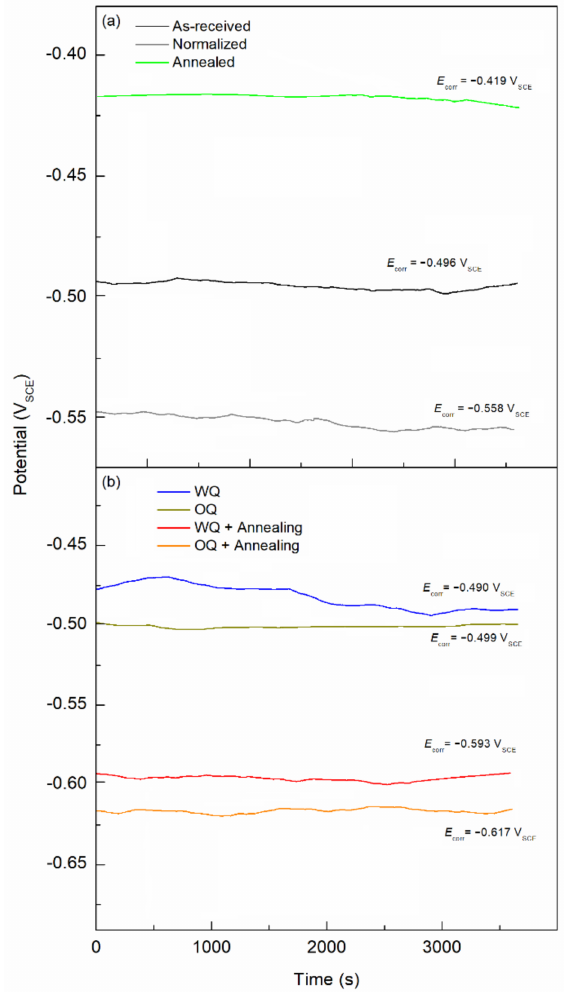
Figure 4. Open circuit potential obtained during 1 h for the sample exposed to FA pore solution containing 0.6 M NaCl with: ( a ) slow cooling rate, and ( b ) fast cooling